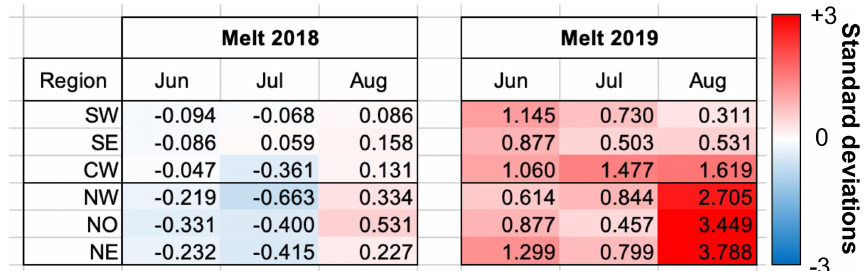
Figure B5. June, July, and August monthly melt anomalies below 2500m from the 1958–2017 mean climatology for each subregion of the GrIS in 2018 and 2019.